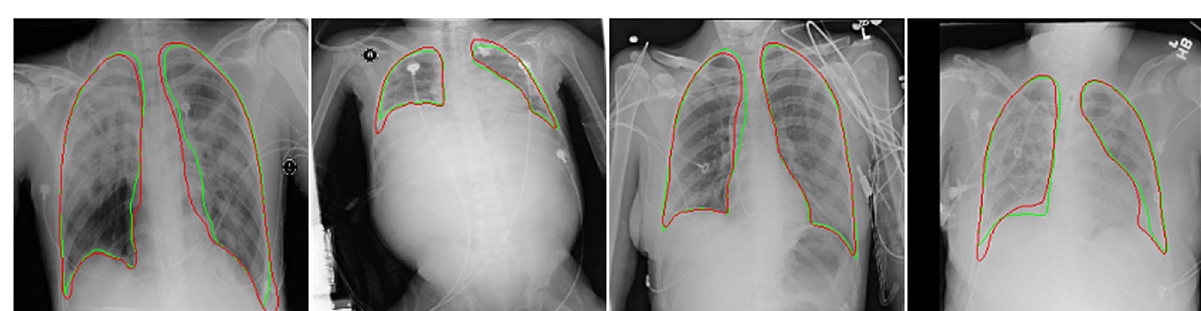
Figure 7. The above is the result of lung segmentation in severe disease (blurred lung area caused by disease) and distorted lung. In those cases, the lung segmentation score is the lowest. The ground-truth lung boundary is depicted in green, and the automatically segmented lung boundary by our method is presented in red